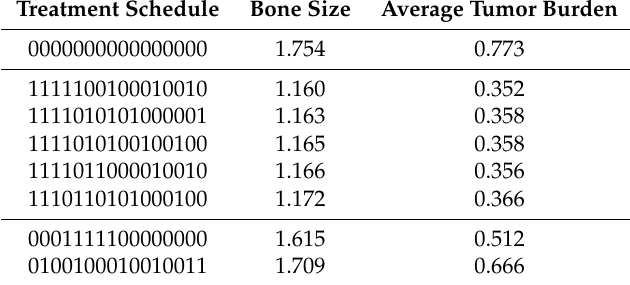
Table 1. The top five treatments as well as an example of continuous and periodic treatments. In the 1st column, each 0 represents a treatment holiday and each 1 represents the application of chemotherapy. The bone size and tumor burden are dimensionless and rounded to three decimal places. Given the qualitative nature of the model, the goal of this table is to show that different treatment schedules impact bone size and tumor burden differently, but the quantitative differences between treatments might not be conserved in